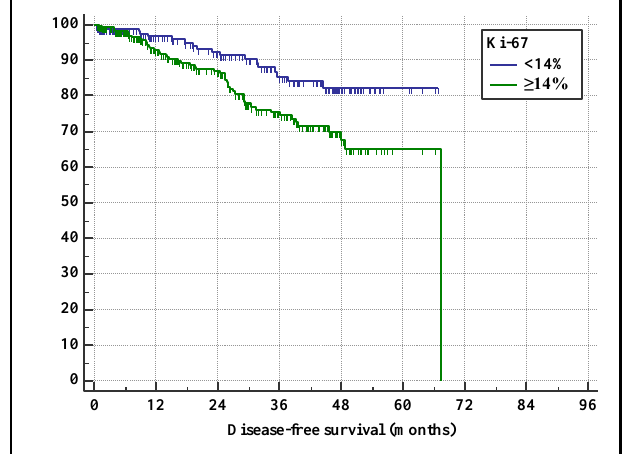
Figure 2: Kaplan-Meier disease-free survival estimates according to Ki-67 cutoff value of 14%